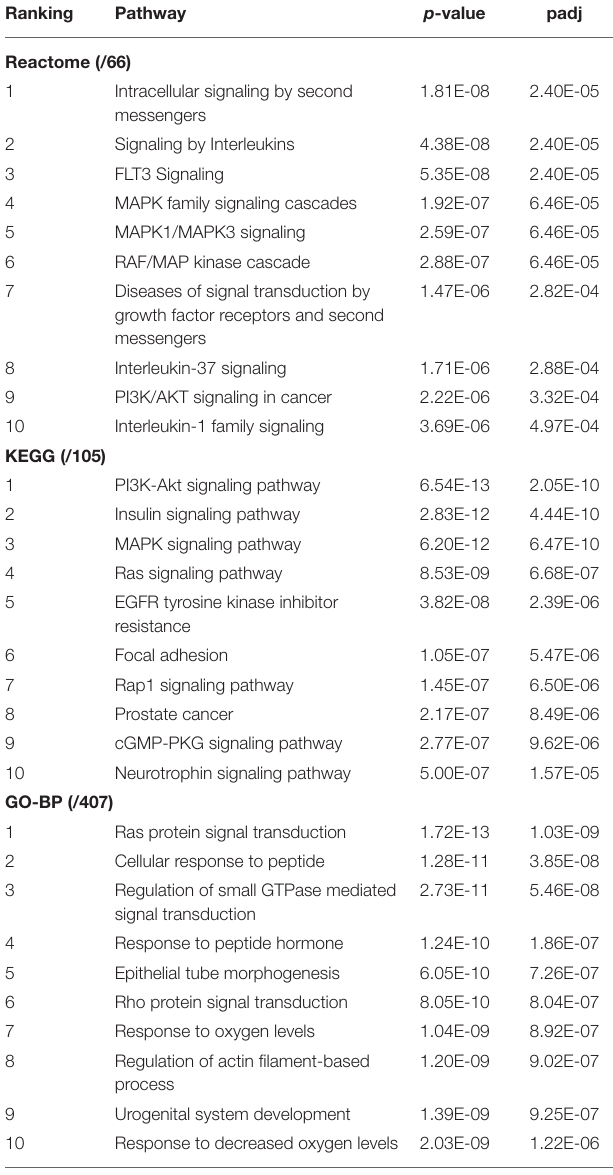
TABLE 4 | Top 10 signaling pathways and biological processes in integration